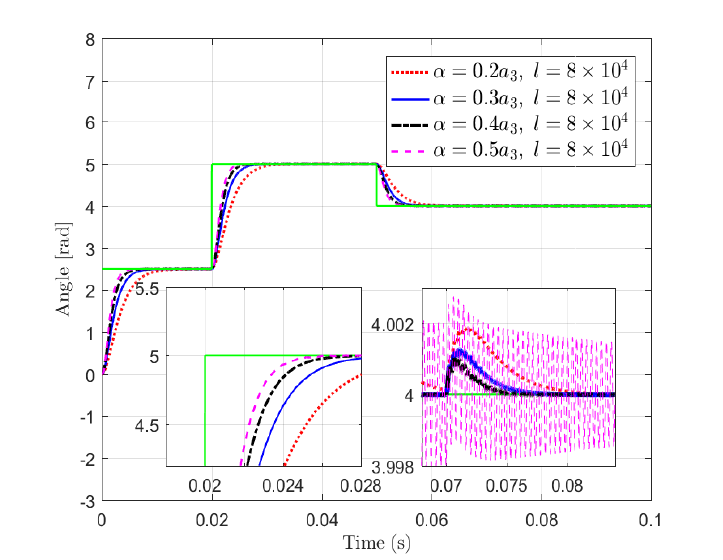
Figure 11. Performance comparison of ROPIO compensated ROMBC by increasing α with l = 8 × 10 4 . In the root locus plots in Figure 12, it is seen that as the value of α increases the root trajectories approach the imaginary axis. Thus, the most crucial information gathered from this revelation is the existence of a trade-off between transient performance and disturbance rejection ability for the ROPIO compensated ROMBC. Increasing the value of α improves transient performance, while reducing its flexibility to work with high-gain observer that can be used to improve robustness against system uncertainties and external disturbances.